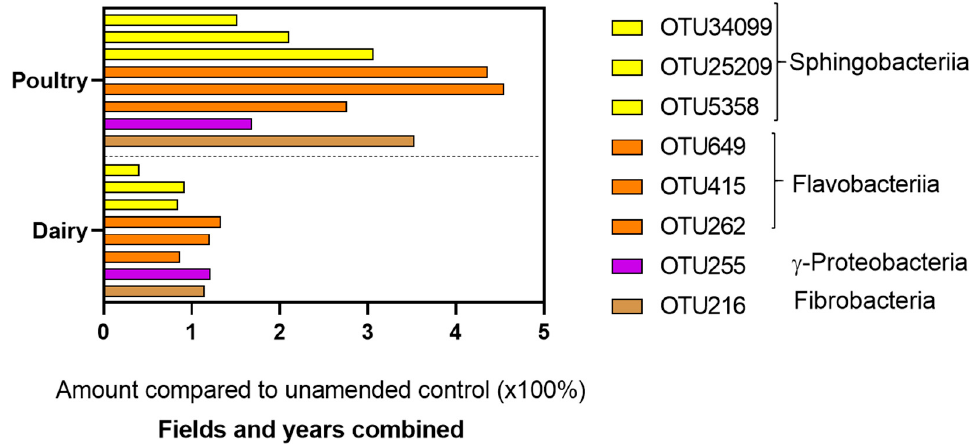
Figure 3. Order of magnitude in amplicon abundance compared to the no-compost control. Both fields and three years were combined. Bar colors represent phyla Sphingobacteriia (yellow), Flavobacteriia (orange), γ -Proteobacteria (purple), and Fibrobacteria (brown).